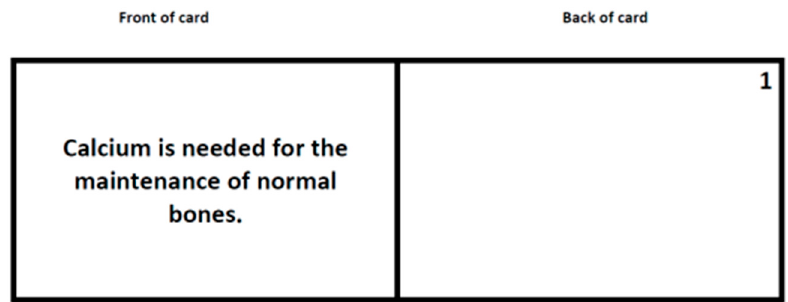
Figure 1. Example of stimuli card number 1 utilised in the study. Table 2. Health claim and nutrition claim stimuli by expert typology and health relationship. Stimuli No.